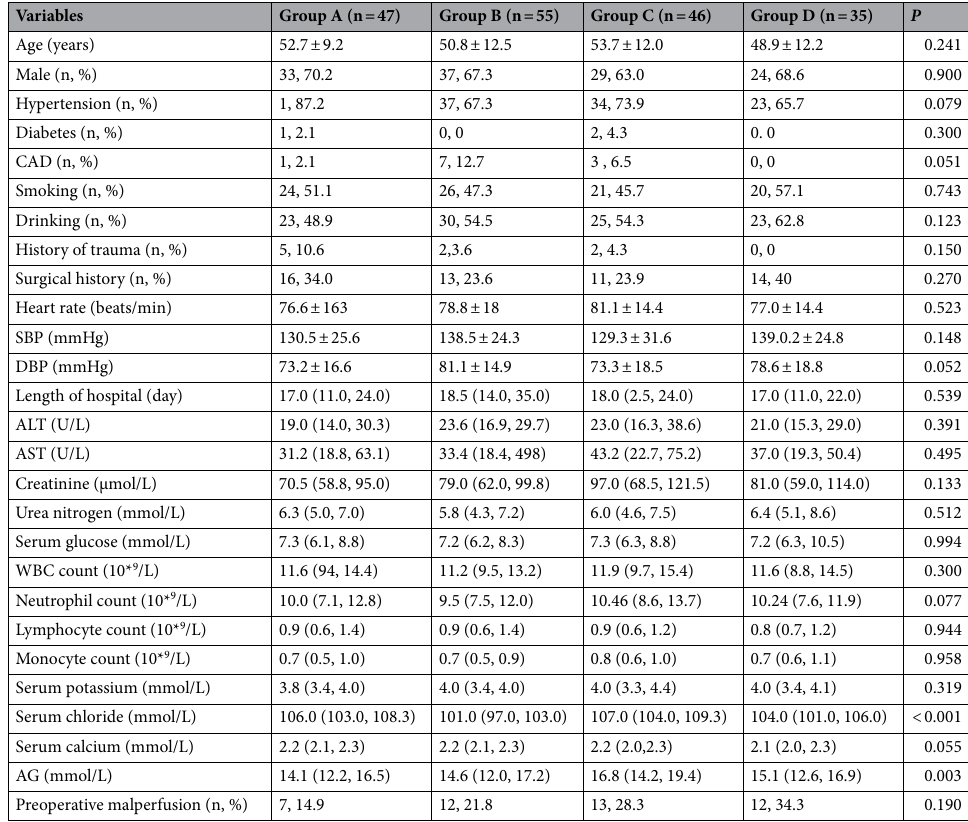
Table 3. Demographic characteristics and clinical data of patients (n = 183). Continuous variables that satisfy normal distribution are expressed by mean and standard deviation, and continuous variables that do not satisfy normal distribution are expressed by median and quartile. Categorical variables are expressed by number and percentage. Group A, CO 2 CP ≥ 22.5 mmol/L + serum sodium >138.5